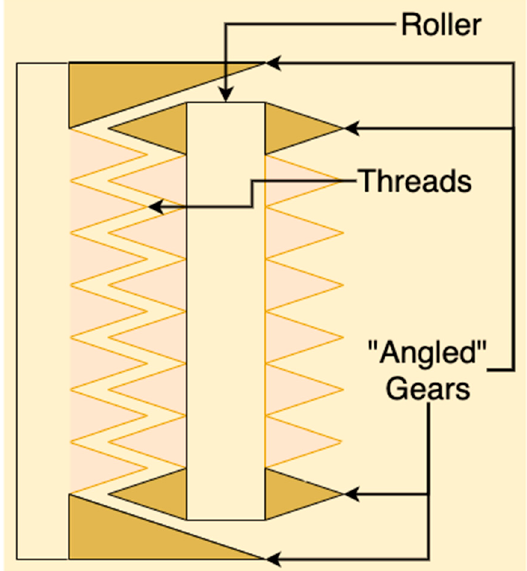
Figure 9. Schematic of roller encapsulation method using “Angled” gears.